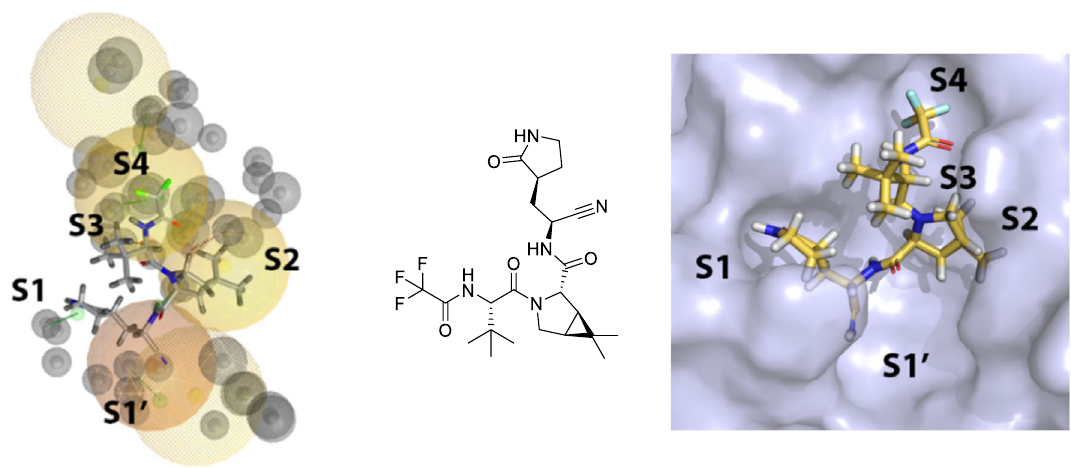
Figure 7. Ligand pose of Nirmatrelvir obtained through CM-2 on the left. Experimental ligand pose of Nirmatrelvir on the right. (PDB 7SI9) The nitrile group in the experimental pose does not appear correctly as it is covalently bonded to the protease. HBD (green), HBA (red), hydrophobic (yellow), residue bonding point (orange), and exclusion volume